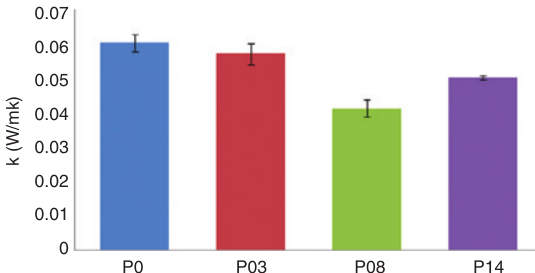
Figure 7: Thermal conductivity of the polypropylene filaments.